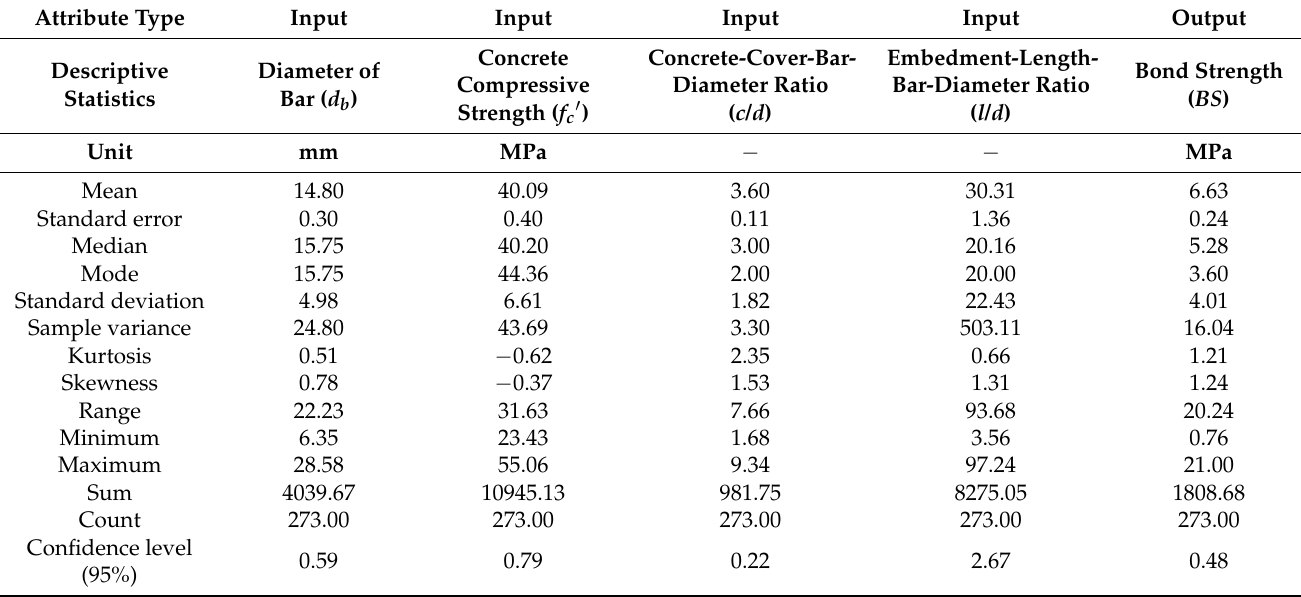
Table 1. Descriptive statistics of the database used to develop